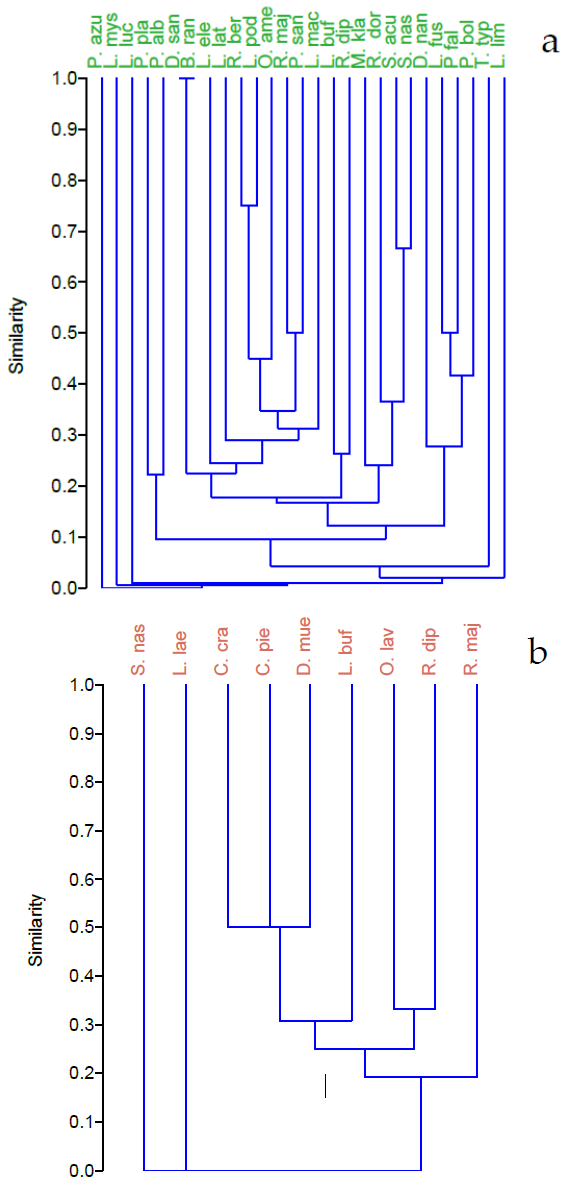
Figure 6. Dendrogram for cluster analysis (UPGMA) using the Jaccard’s Similarity Index between species of amphibians with respect to the presence of nematode parasites in Humid Chaco ( a ) and Dry Chaco ( b ). Rhinella bergi , R. ber; R. diptycha , R. dip; R. dorbignyi , R. dor; R. fernandezae , R. fer; R. major , R. maj; Melonophryniscus klappenbachi , M. kla; Ceratophrys cranwelli , C. cra; Chacophrys pierottii , C. pie; Lepidobatrachus laevis , L. lae; Boana raniceps , B. ran; Dendropsophus nanus , D. nan; D. sanborni , D. san; Lysapsus limellum , L. lim; Pseudis platensis , P. pla; Scinax acuminatus , S. acu; S. nasicus , S. nas, Trachycephalus typhonius , T. typ; Dermantonotus muelleri , D. mue; Leptodactylus bufonius , L. buf; L. elenae , L. ele; L. fuscus , L. fus; L. latinasus , L. lat; L. luctator , L. luc; L. macrosternum , L, mac; L. podicipinus , L. pod; Physalaemus albonotatus , P. alb; P. santafecinus , P. san; Pseudopaludicola falcipes , P. fal; P. boliviana , P. bol; Odontophrynus americanus , O. ame; O. lavillai , O. lav; Pithecopus azureus , P. azu.